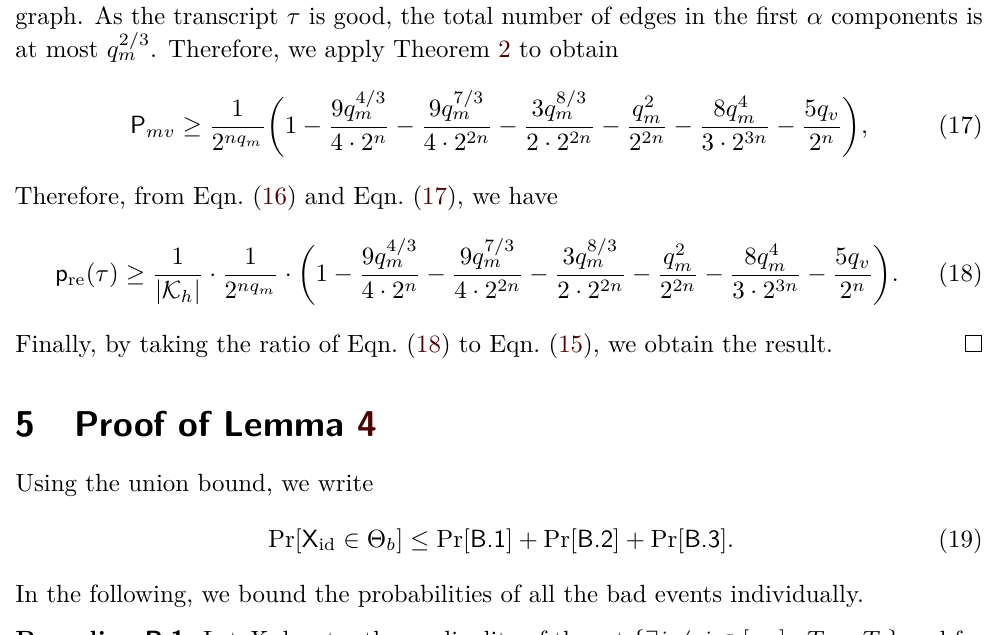
Figure 4.1: (a) star type component and (b) the component with a single